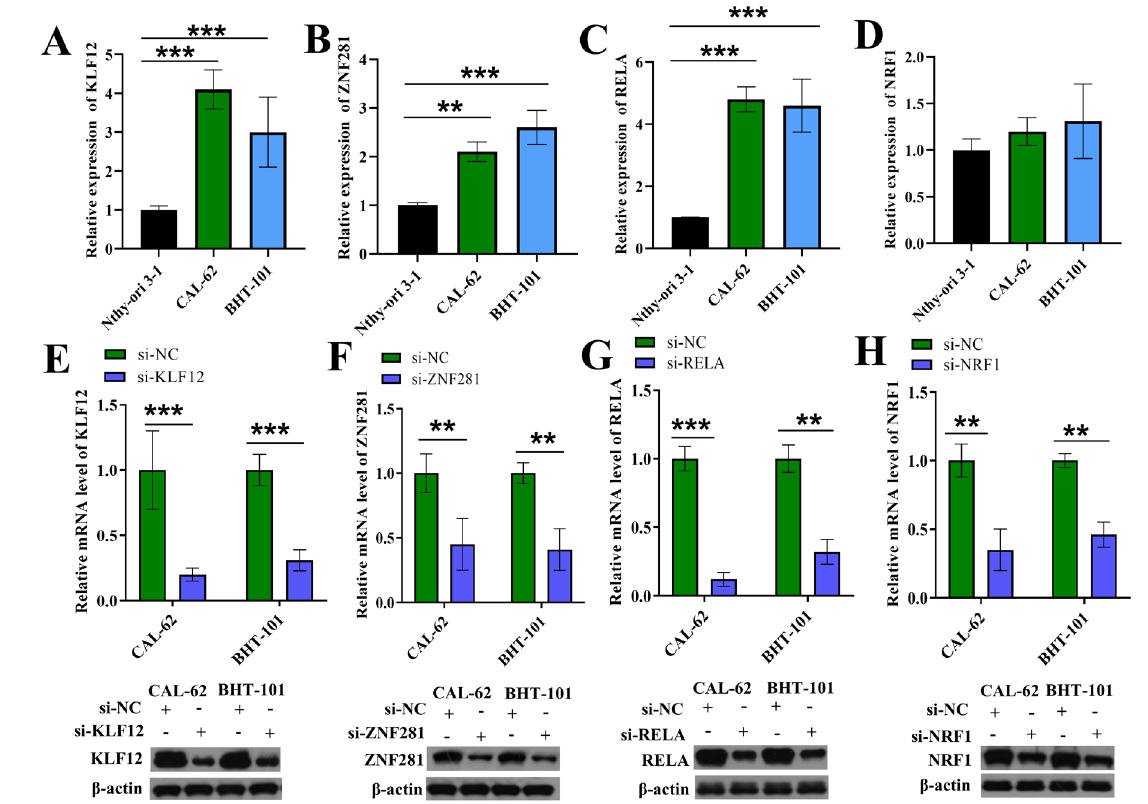
Figure 7. Verification of silencing efficiency of KLF12, ZNF281, RELA and NRF1. (A-D) Expression levels of KLF12 (A), ZNF281 (B), RELA (C) and NRF1 (D) in Nthy-ori 3-1, CAL-62 and BHT-101 cells were measured by qRT-PCR. (E-H) Silencing efficiency of KLF12 (E), ZNF281 (F), RELA (G) or NRF1 (H) in CAL-62 and BHT-101 cells were verified by qRT-PCR and western